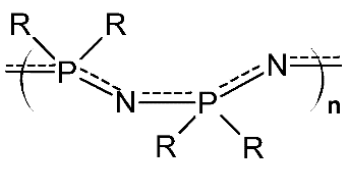
Figure 6. Configuration of the most stable cis,trans-POP isomer.